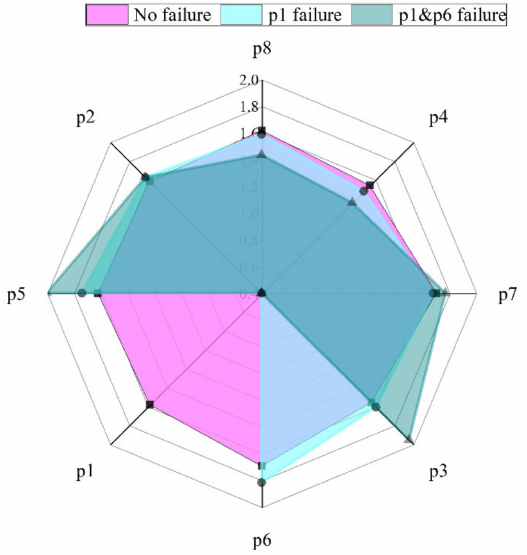
Figure 16. Maximum tension of each tension leg (unit: 10 4